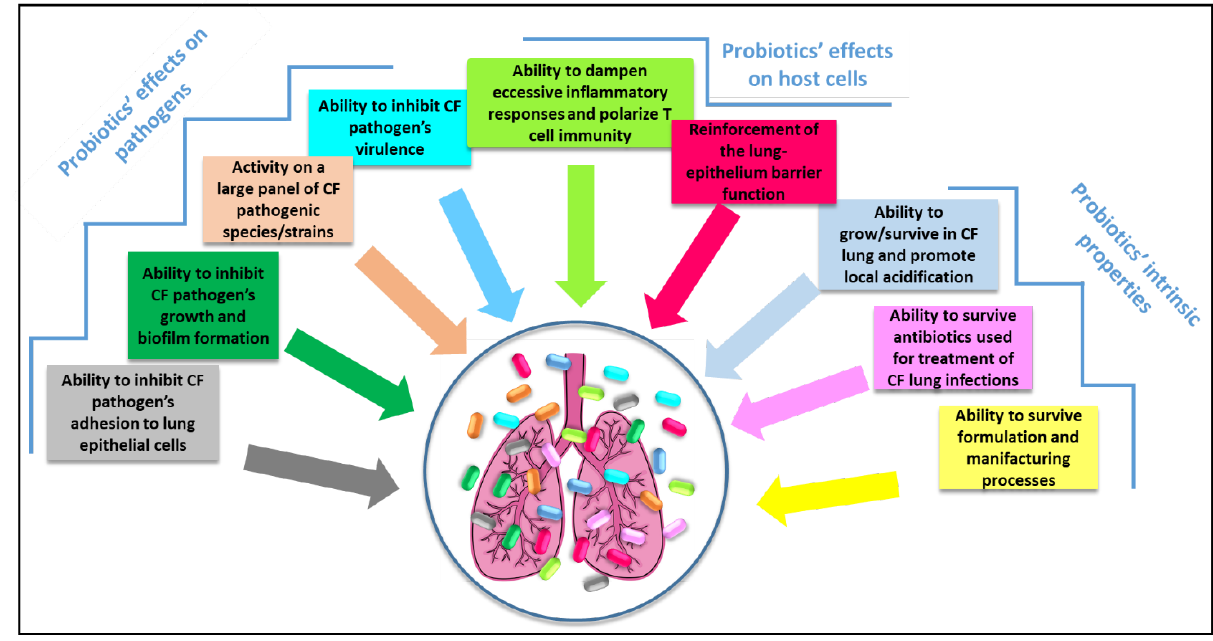
Figure 3. Ideal requirements of a probiotic/probiotic mix for administration to CF patients via the respiratory route that can guide the selection process.